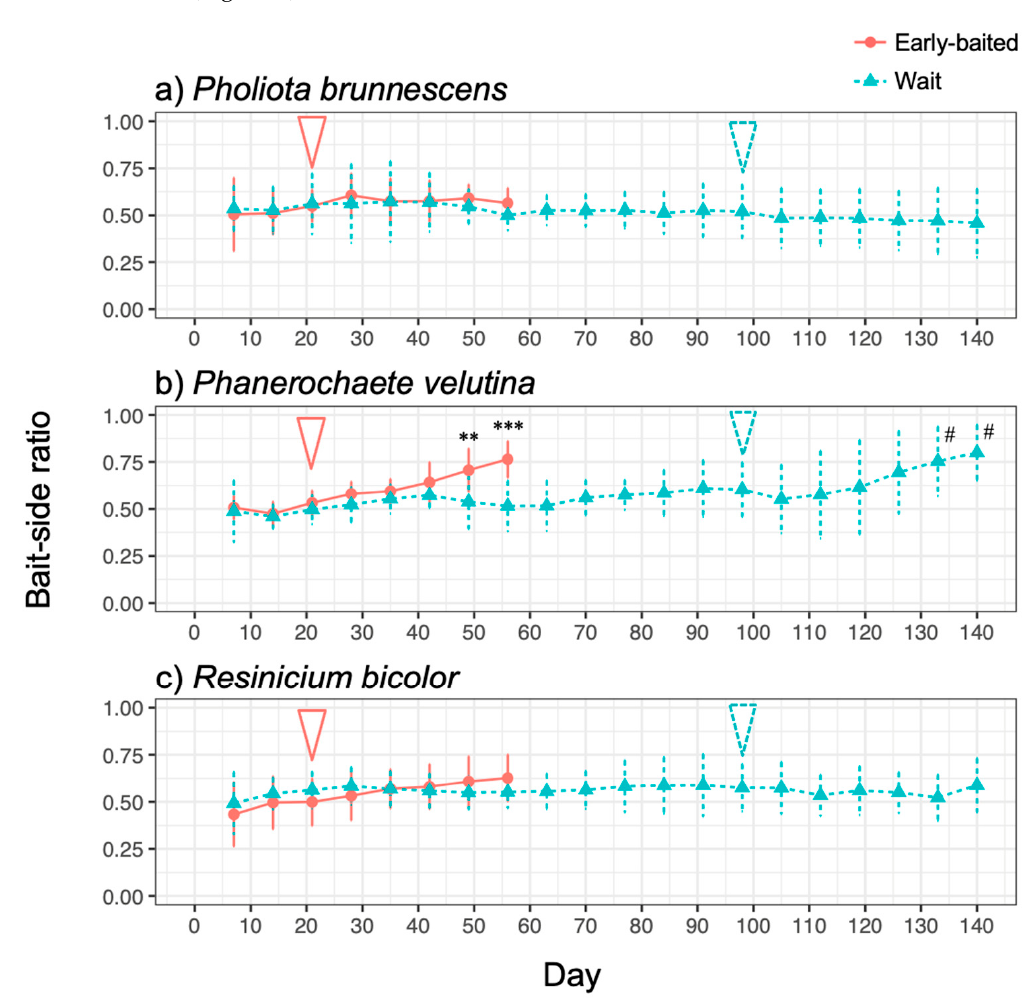
Figure 3. Changes in the bait-side ratio of the hyphal coverage of ( a ) Pholiota brunnescens , ( b ) Phanerochaete velutina , and ( c ) Resinicium bicolor in response to added resources at different times. Pink round plots with a solid line indicate the ‘early-baited’ experiment and blue triangle plots with dotted line indicate the ‘wait’ experiment. The pink solid arrow and blue dotted arrow indicate the time of addition of bait wood blocks to ‘early-baited’ and ‘wait’ experiments, respectively. Plots and error bars indicate mean and standard deviation, respectively ( N = 10). Asterisks indicate significant differences between ‘early-baited’ and ‘wait’ experiments during 7–56 d: ** p < 0.01; *** p < 0.001 (repeated measures ANOVA). Hashtags indicate significant difference from 0.5 in wait experiment (Wilcoxon rank-sum test: # p < 0.05).